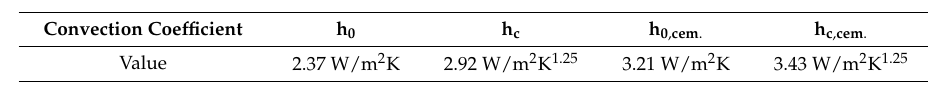
Table 2. Summary of the convection coefficient used in the analytic model. During the thermal dissipation tests, the surrounding temperature T s was fixed at 297 K, L c of the testing samples; the cement resistors were 4.13 × 10 − 2 m and 2.82 × 10 − 2 m, respectively; the C values of the testing were between 10 5 and 10 6